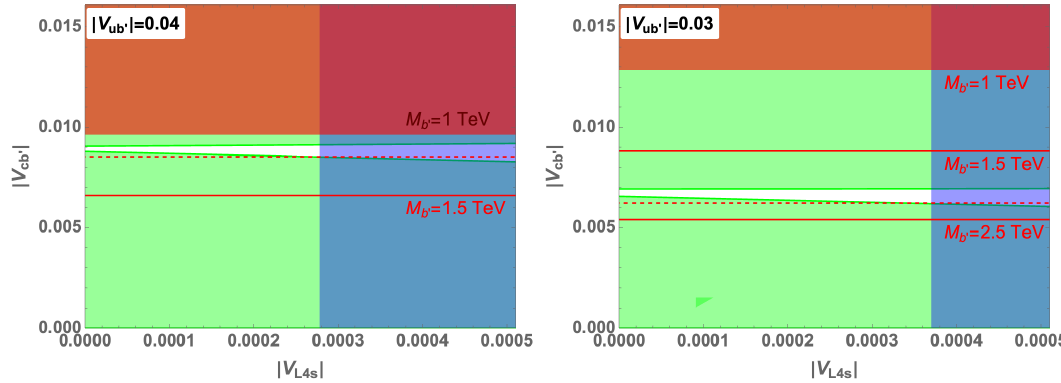
Figure 12 . Constraints on | V cb 0 | and | V L 4 s | . On the left, | V ub 0 | ≈ | V L 4 d | = 0 . 04 . The red area is excluded by the constraints on | V cb 0 | from D 0 systems, with M b 0 = 1 TeV, as reported in table 6. The red lines show where the boundary shifts if the mass of the extra quark is taken as M b 0 = 1 . 5 . The red dashed line indicate the boundary of the excluded area if the new contribution to D-mesons mass difference is equal to the central experimental value (4.101). The blue area is excluded by flavour changing processes involving K-mesons, using the result | V L 4 s | < 3 . 7 · 10 − 4 , from figure 11, . 0 . 3 π . The green region eq. (4.148), which is allowed by every single process for − 3 / 2 π . δ d L 21 is excluded by the relation in eq. (4.151), for the considered values of the relative phase δ d . On L 21 the right, the same constraints are shown setting | V ub 0 | ≈ | V L 4 d | = 0 . 03 . The constraint on | V cb 0 | from D-mesons mixing (red area) is lowered to the red lines taking the mass of the extra quark as M b 0 = 1 . 5 TeV, M b 0 = 2 . 5 TeV. The red dashed line indicate the boundary of the excluded area under more stringent assumptions. In particular, the new contribution to D-mesons mass difference is limited as one third of the experimental value